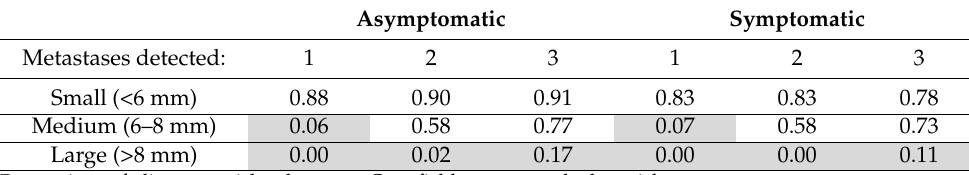
Proportions of oligo+ per risk sub-group. Grey fields represent the low-risk group. Table A3. Proportion of oligo+ within patients with detected oligo-metastases in the RFS Lower scenario. Asymptomatic Symptomatic